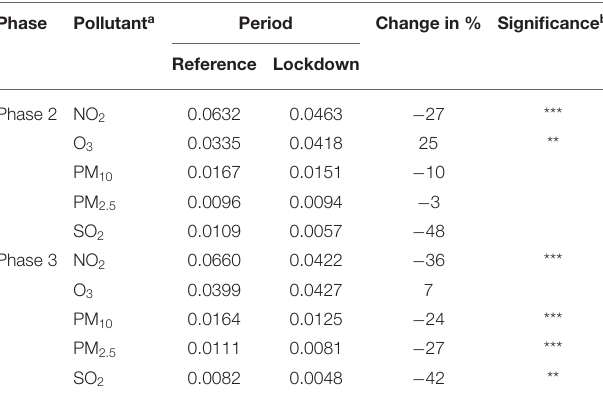
TABLE 4 | Average excess risk within the MCMA for each criteria air pollutant during 2016–2019 (Reference) and COVID-19 lockdown Phases